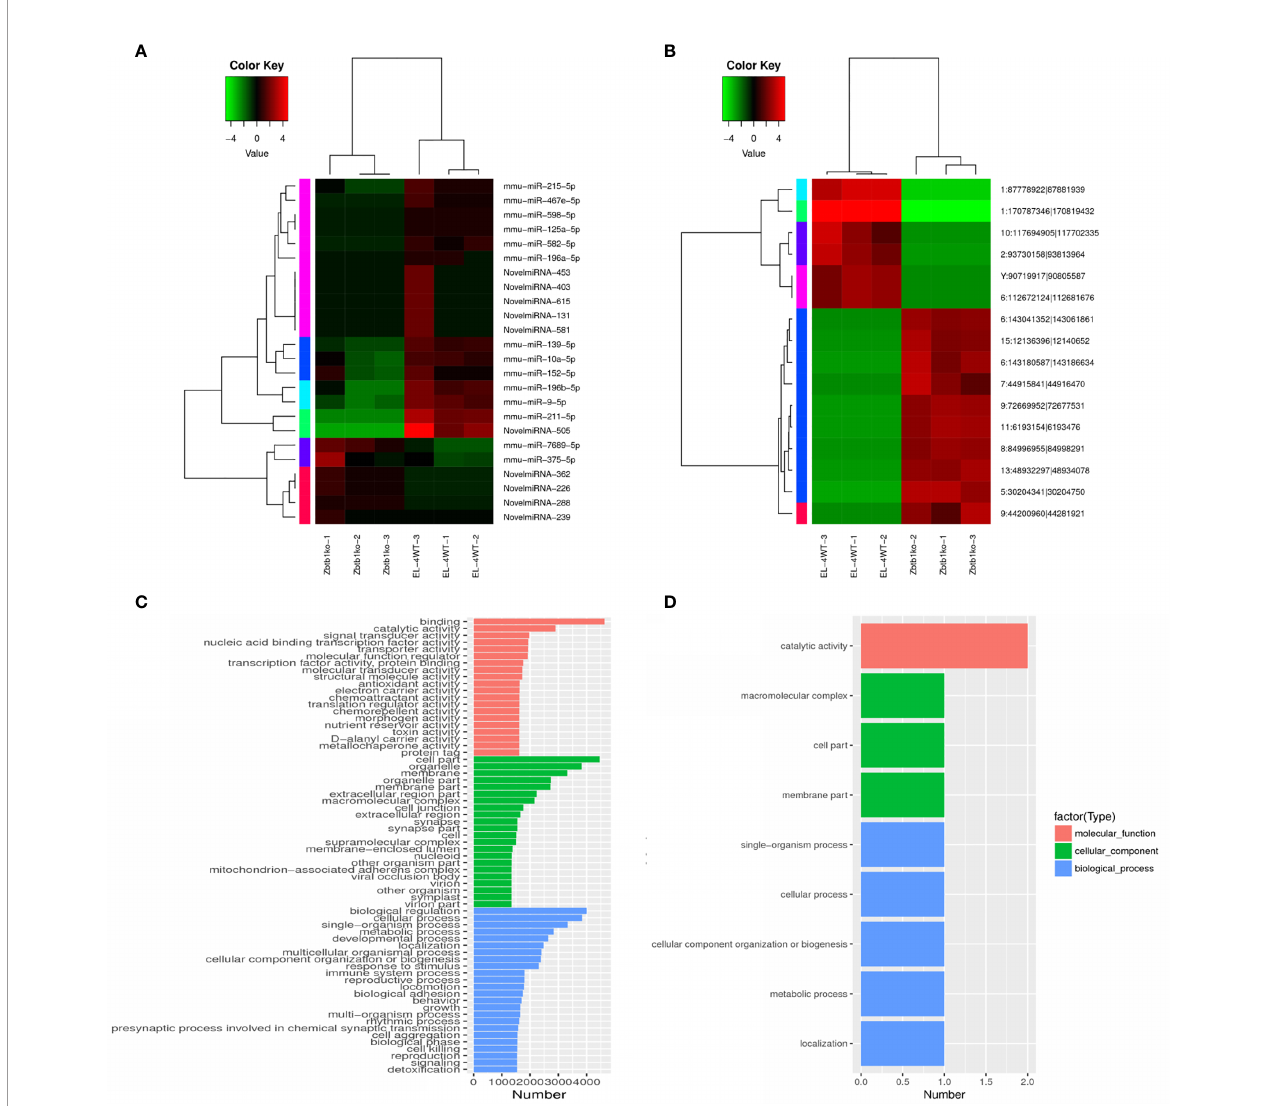
FIGURE 3 | Cluster map of differentially expressed microRNAs and circRNAs according to the log2SRPBM value. Red indicates high expression, and green indicates low expression. The color from green to red indicates higher expression. (A) Cluster map of differentially expressed microRNAs; (B) Cluster map of differentially expressed circRNAs; GO enrichment histogram. The ordinate is the enriched GO term, and the abscissa is the number of differentially expressed microRNA target genes and circRNA source genes corresponding to the term. Different colors are used to distinguish biological processes, cellular components and molecular functions. (C) GO enrichment histogram of differentially expressed microRNA target genes; (D) GO enrichment DAG diagram of differentially expressed circRNA source genes in columnar